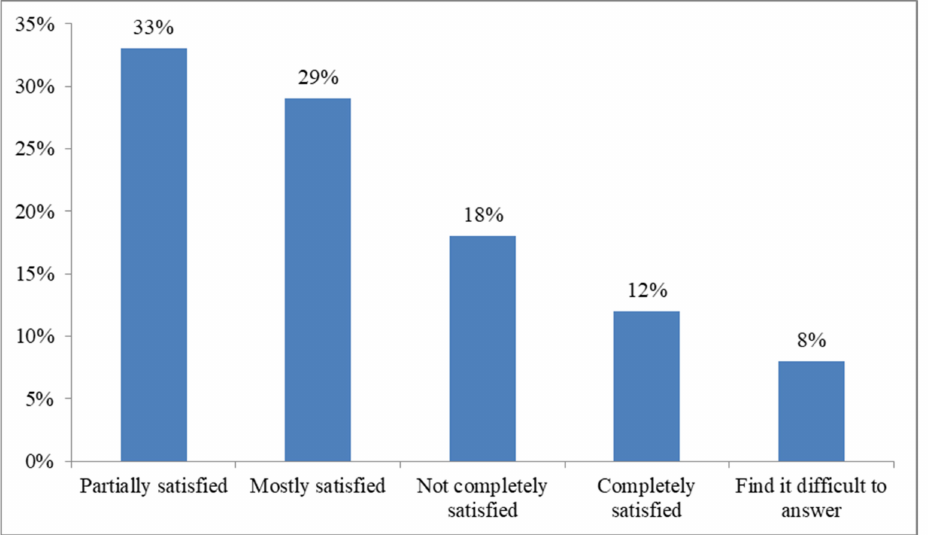
Figure 14. The degree of satisfaction of the respondents from manufacturing enterprises of the Republic of Mordovia in the use of ICT in their